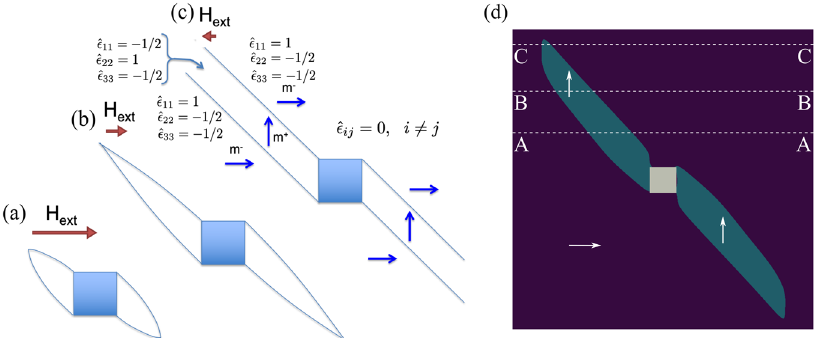
Fig. 6 Schematic of the metastability of the Néel spikes. a With large applied fi eld the spikes are collapsed onto the nonmagnetic defect, stabilized by (diffuse) domain wall and demagnetization energy. b As the applied fi eld is decreased, the spikes grow, so as to decrease magnetostrictive and demagnetization energies. c The associated energy barrier is breached at small negative applied fi elds, and the spikes run to the boundary. The state ( c ) is transient, and precedes the full switch to the lower energy ½ 100 (cid:5) magnetization; the fi nal state is like ( a ) except the spike domains are pointing NE and SW (see Fig. 4e). d An example simulation of the spike domain at its transient domain state during magnetization reversal. Labels “ AA ” , “ BB ” , and “ CC ” mark lengths across which we examine the strain distribution in Fig.